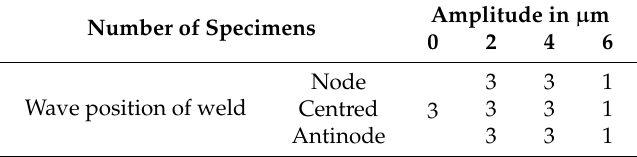
Table 3. Test plan for ultrasound assisted laser beam welding of nickel-base alloy round bars. Amplitude in µ m Number of Specimens Wave position of weld